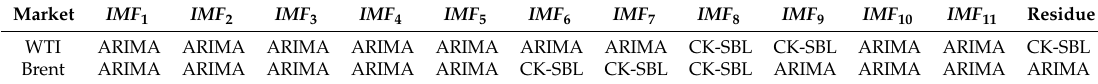
Table 16. Prediction model selection for each component on WTI and Brent crude oil prices.